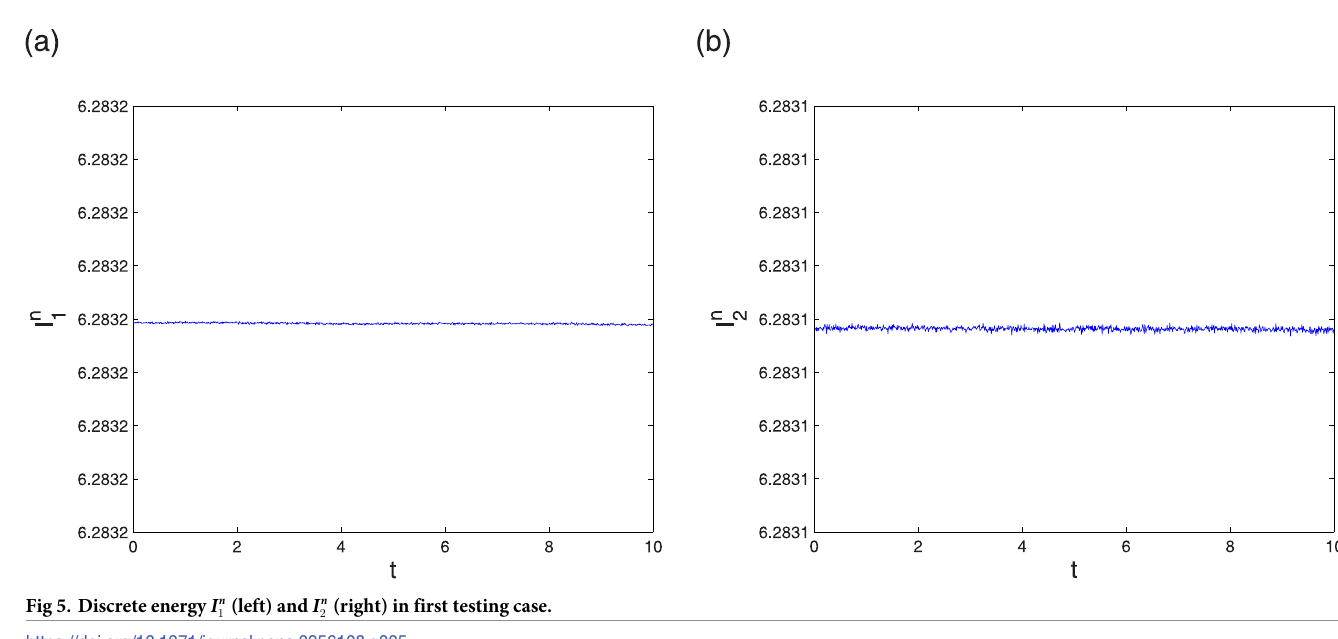
(left) and I n (right) in first testing case. 1 2